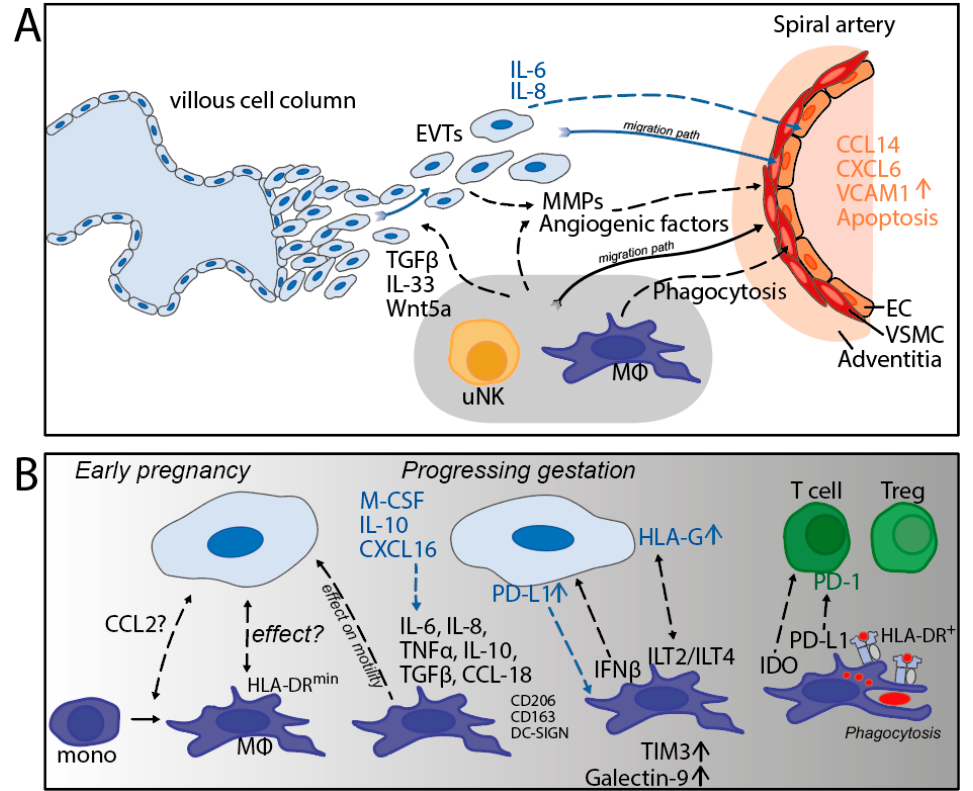
Figure 4. ( A ) Involvement of decidual macrophages during early pregnancy. ( B ) The role of macrophages during gestation and its interactions with trophoblasts and T cells. EVTs = extravillous trophoblasts; EC = endothelial cells; VSMC= vascular smooth muscle cells; MMPs = matrix metalloproteases. black dotted lines: effect of macrophages on surrounding cells; blue dotted lines: effect of trophoblasts on surrounding cells.